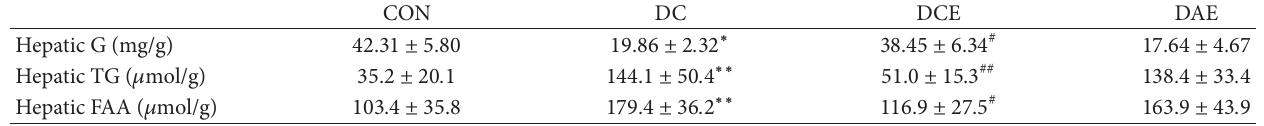
Table 2: The effects of exercise on liver glycolipid storage in type 2 diabetes